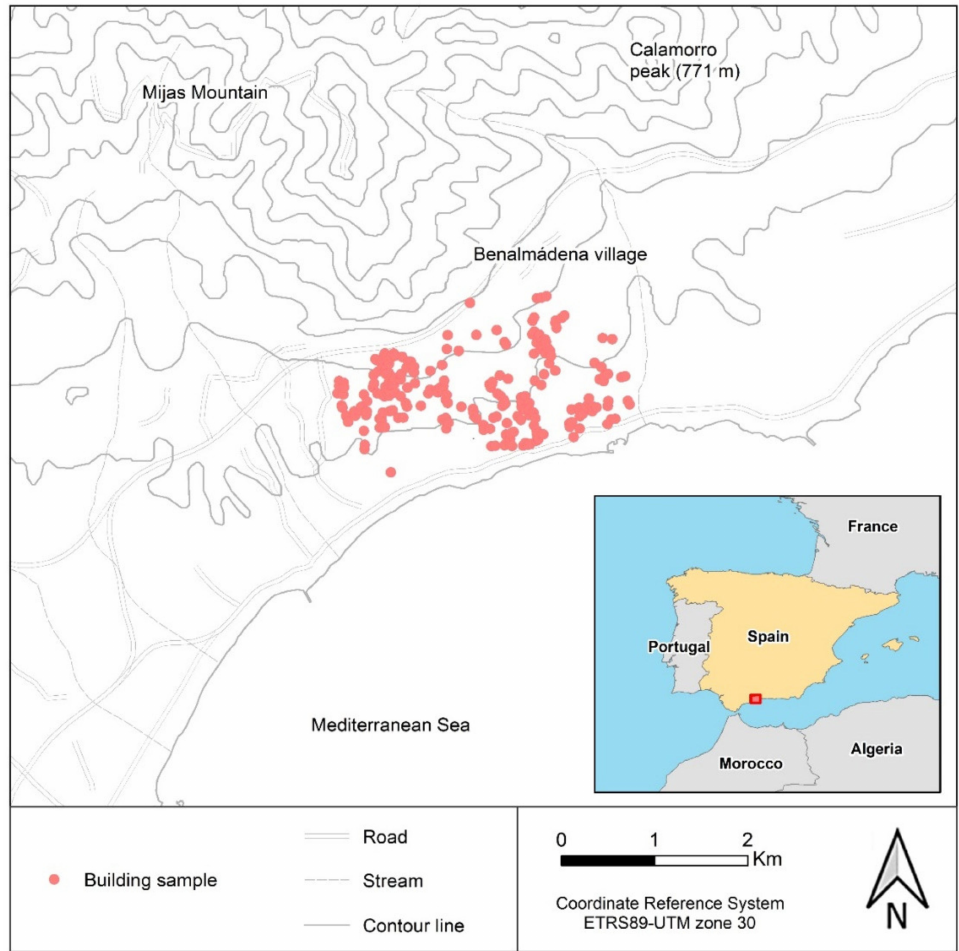
Figure 2. Location of the study area (own